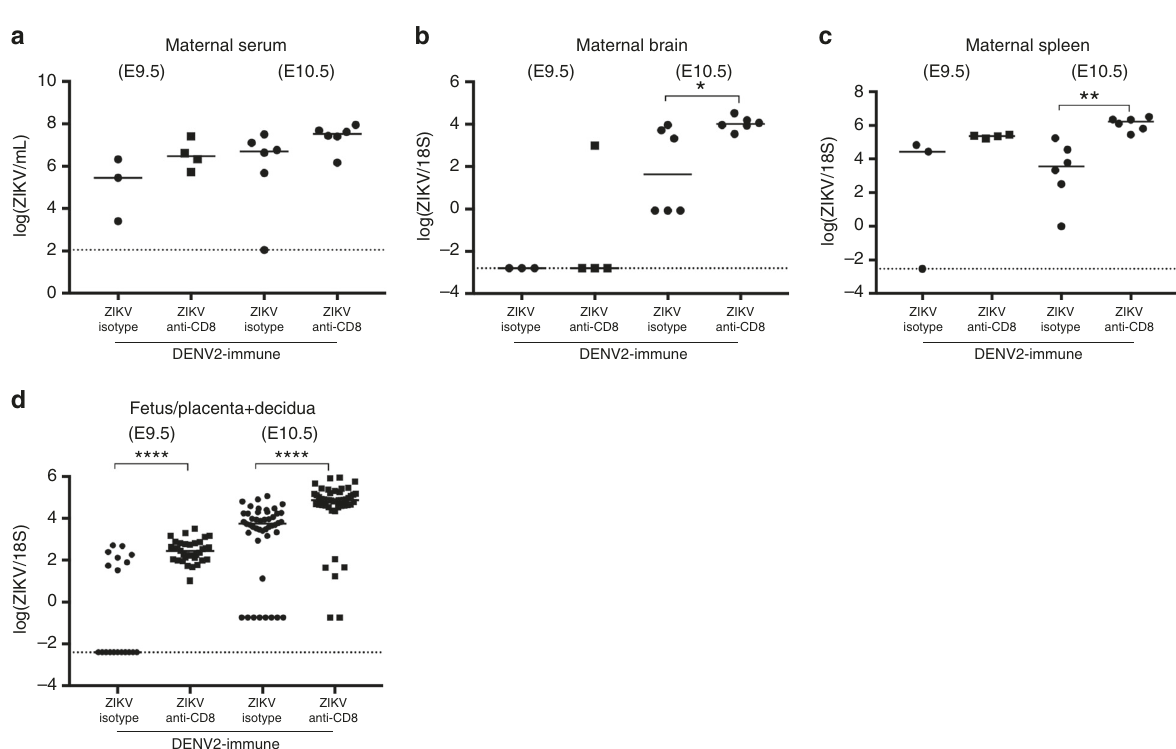
Fig. 3 ZIKV burden in Ifnar1-blocking Ab-treated WT dams and their fetuses on days 2 and 3 after ZIKV infection. DENV2-immune WT dams were treated with anti-Ifnar1 mAb and challenged with ZIKV at E7.5 as described in Fig. 2. Mice were administered isotype control or anti-CD8 Ab, also as described in Fig. 2. On days 2 and 3 after ZIKV challenge (E9.5 and E10.5), ZIKV RNA levels in maternal a serum, b brain, and c spleen and d fetus + placenta + decidua were measured by qRT-PCR. n = 19 fetuses from three separate mothers (ZIKV + isotype) and n = 35 fetuses from four separate mothers (ZIKV + Anti- CD8) at E9.5. n = 46 fetuses from six separate mothers (ZIKV + isotype) and n = 48 fetuses from six separate mothers (ZIKV + Anti-CD8) at E10.5. Data were pooled from two independent experiments. Data are expressed as median. * p < 0.05, ** p < 0.01, **** p < 0.00001. Two-tailed Mann – Whitney test